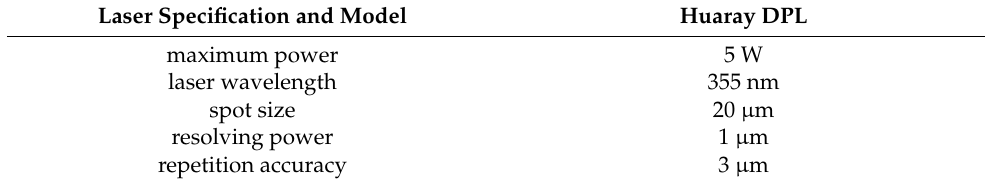
Table 1. AutoCAD software was used to draw the vector graph of electrode contour, and Ezcad software was used to mark the graph and control the cutting of copper foil. Table 1. Main parameters of the laser.